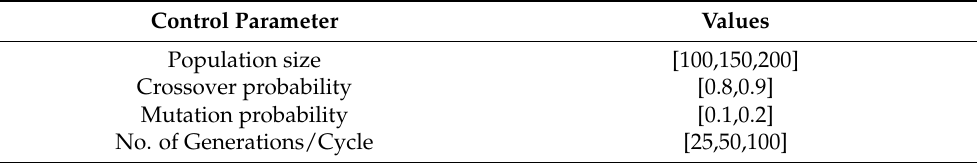
Table 1. GA control parameters